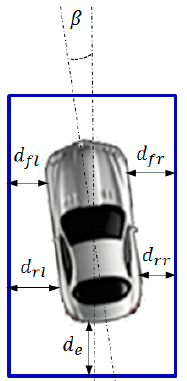
Figure 19. Measurement of parking attitude.